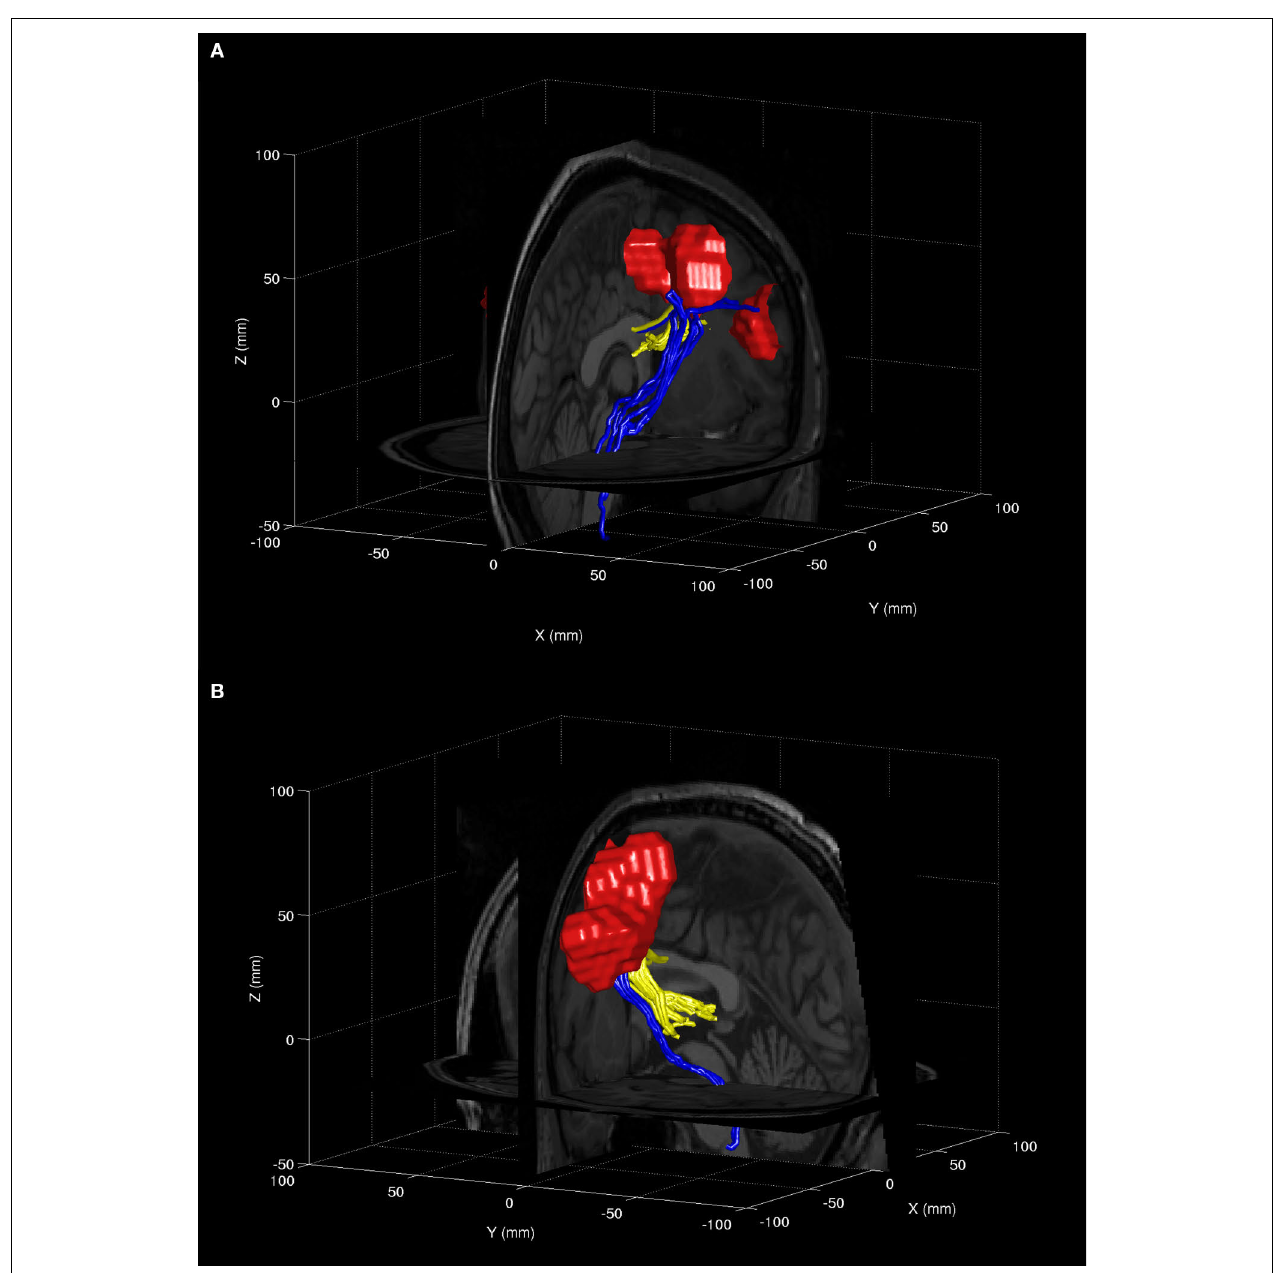
FIGURE 3 | Reconstructed DTI fi ber tracts from different regions of the FEF leading to the SC (blue) or the CN (yellow) for two different individual participants (A,B). Activity around the FEF as determined with the ‘localizer’ task is rendered in